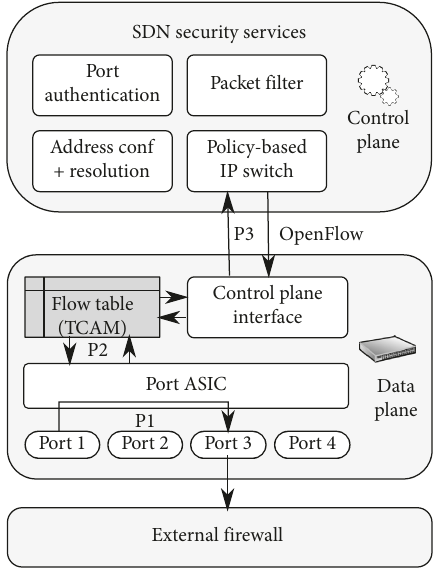
Figure 5: Openflow-based secure